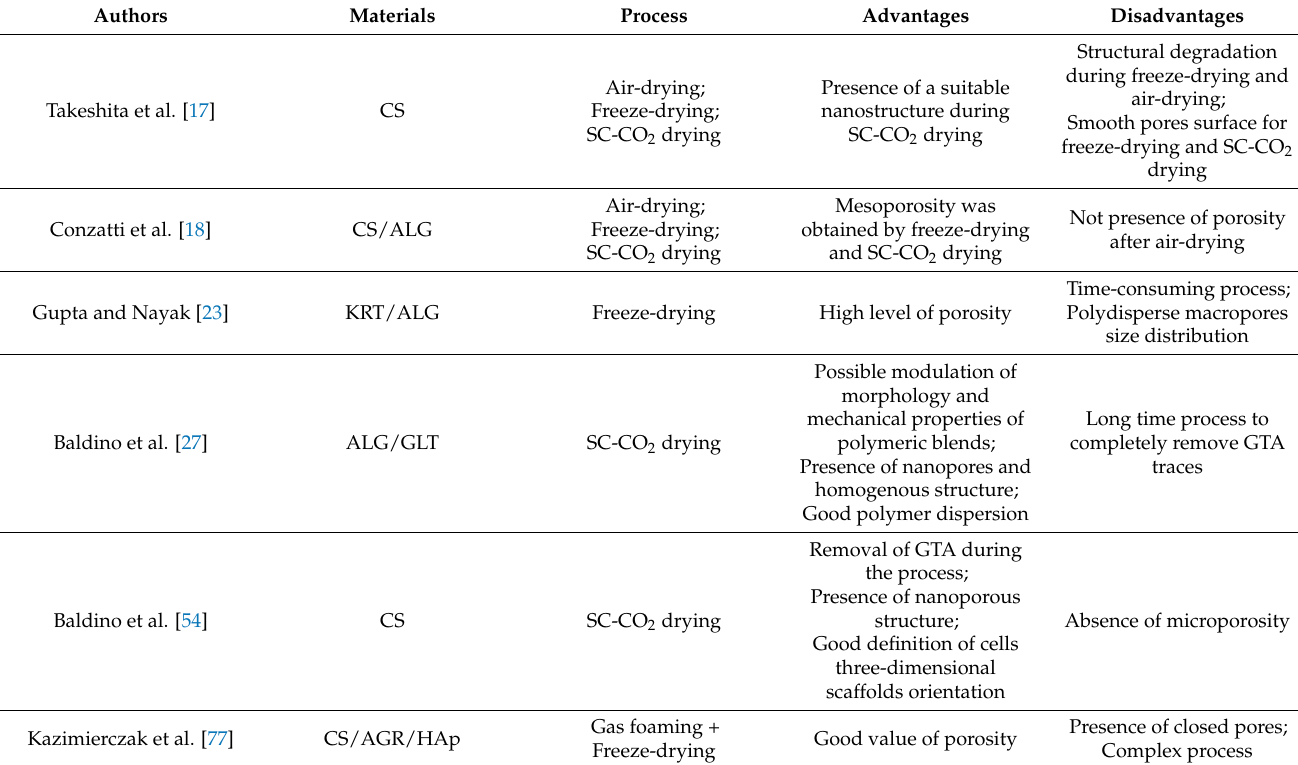
Table 2. Gels applied to bone